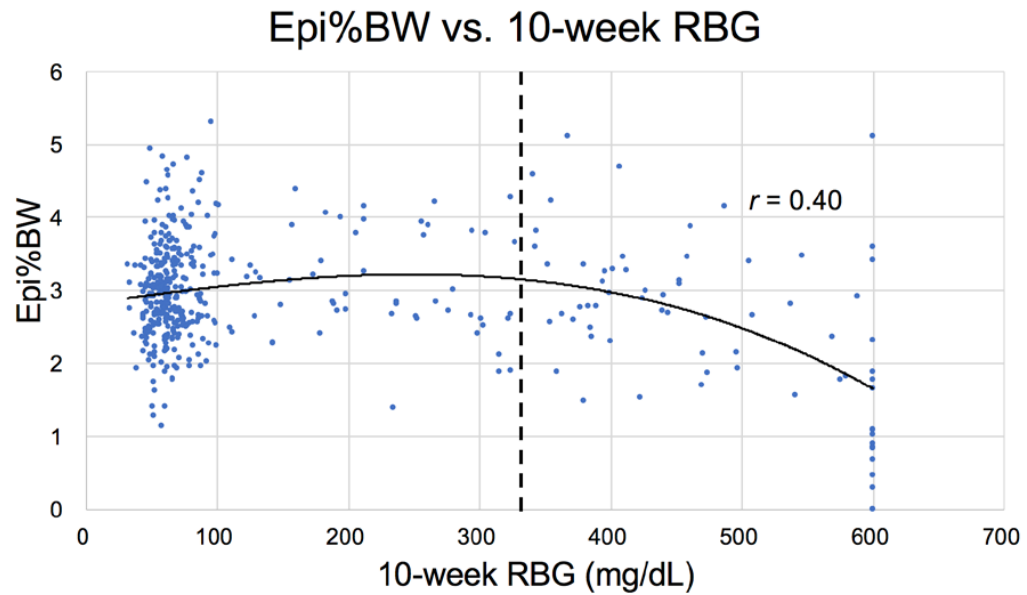
Figure 11. Epi fat pad %body weight (Epi%BW) plotted against random blood glucose after 10 weeks of diet from weaning ( n = 439). Rising RBG represents the increasing likelihood of ketosis with fat loss, indicated by vertical bar and data points greater than 325 mg/dL.